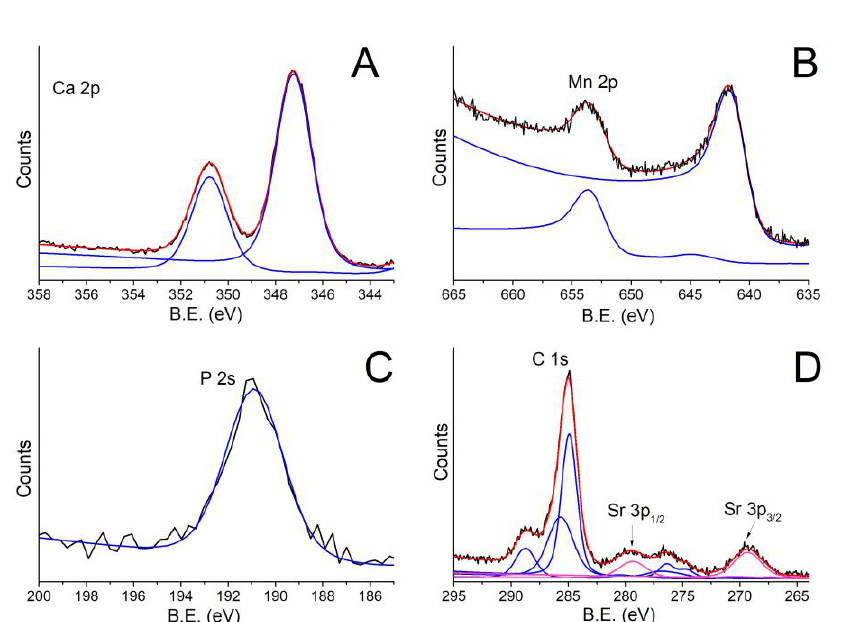
Figure 4. XPS spectra of Mn,Sr-TCP coating deposited on Zn-Li alloy: ( A ) Ca2p; ( B ) Mn2p; ( C ) P2s; ( D ) C1s-Sr2p. In the figure, black, red and blue lines represent the experimental data, the fitting curves and the peak components, respectively.